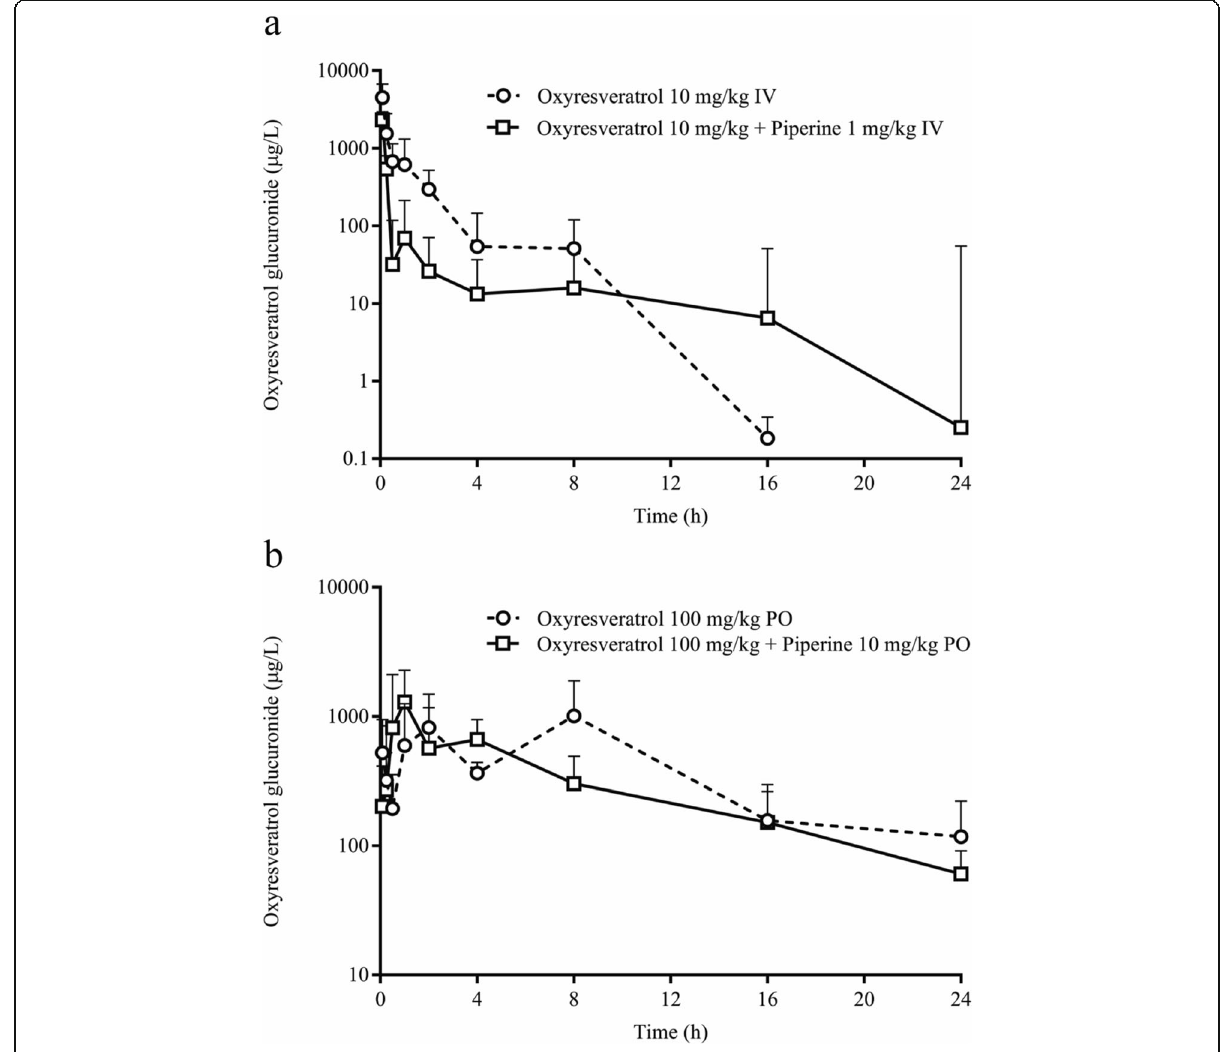
Fig. 4 Plasma concentration – time profile of oxyresveratrol glucuronide after intravenous dose ( a ); after oral dose ( b